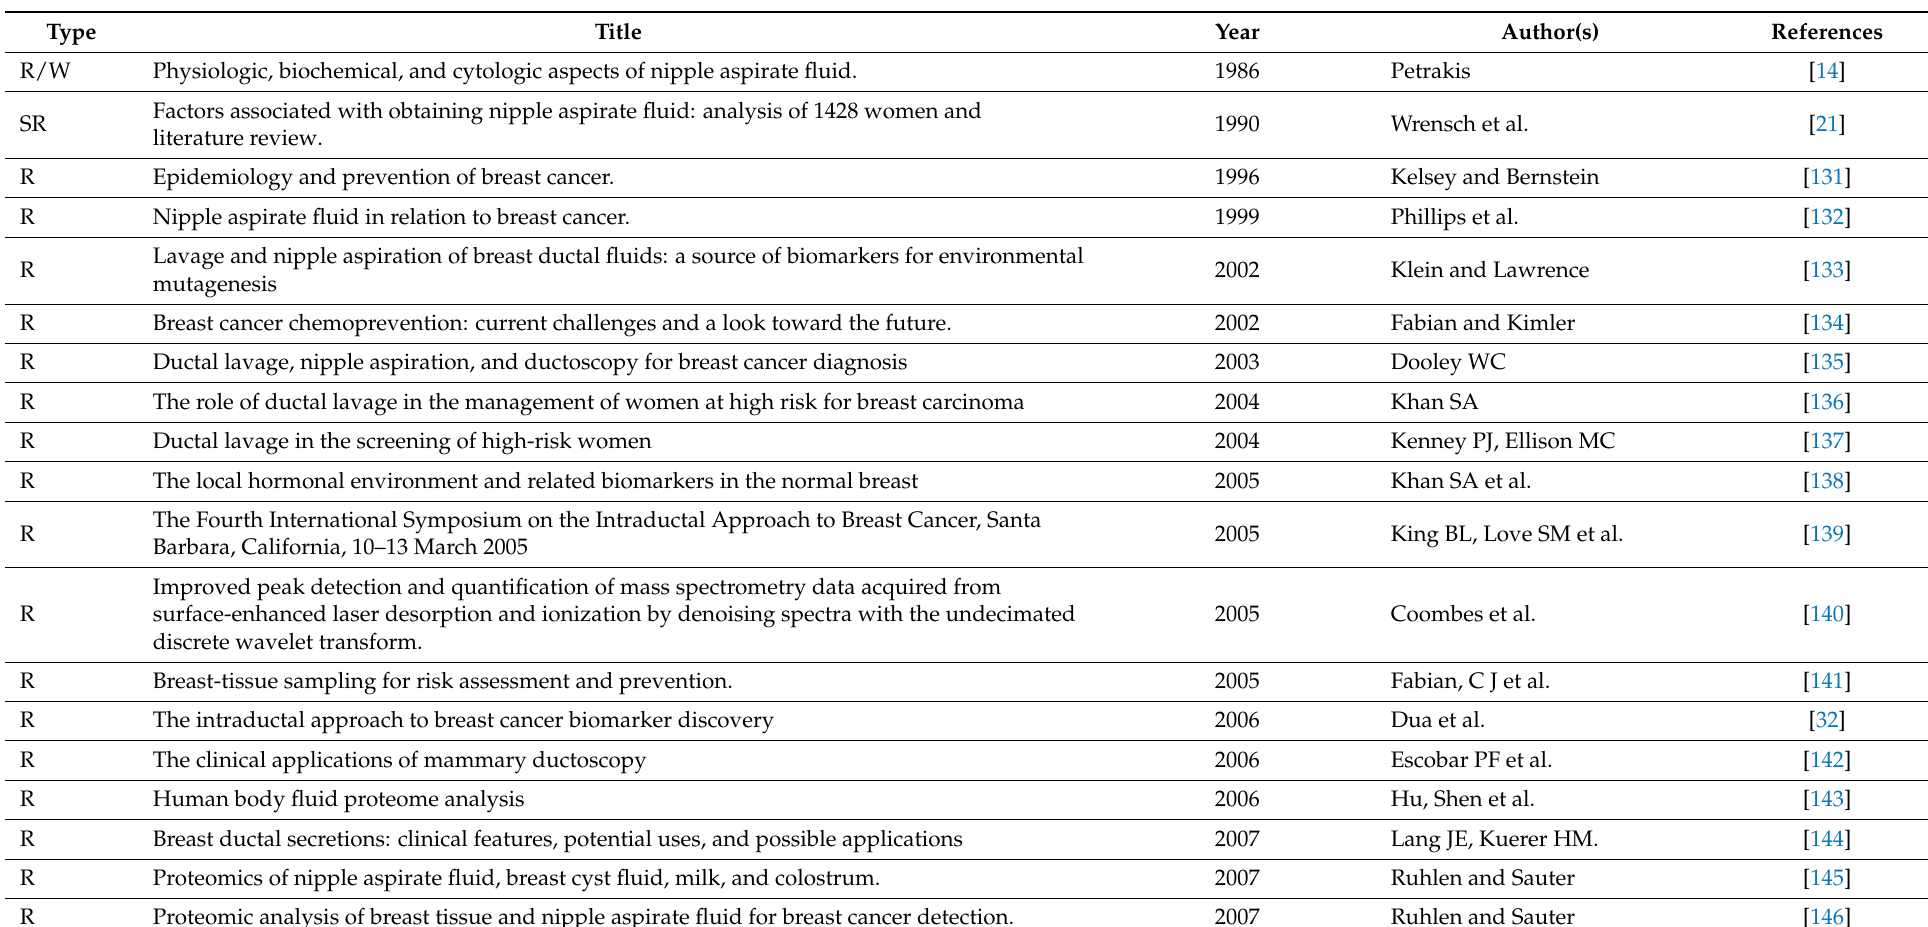
Table 4. List of reviews about nipple aspirate fluid or where nipple aspirate fluid is mentioned amongst other approaches in the manuscript. Abbreviations: R, review; SR, systematic review; W,